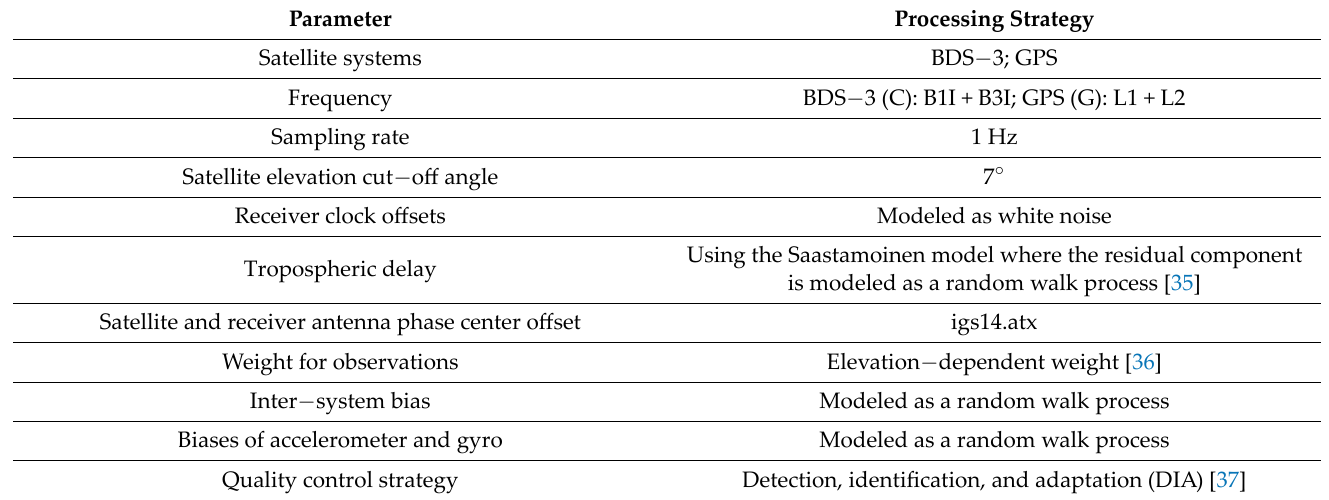
Table 2. Processing strategy of PPP − B2b/INS.